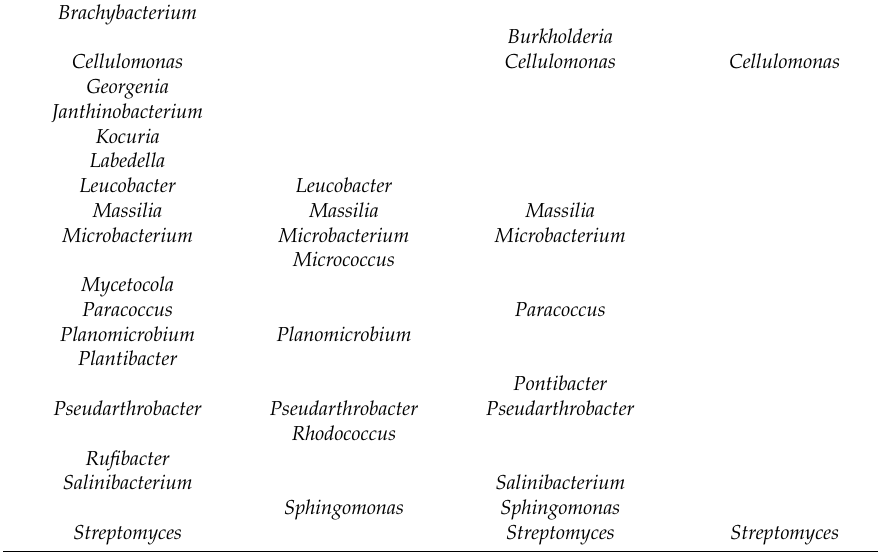
Table A3. The bacterial genera cultured from the Mojave Desert soil sample on different media. The table summarizes data of community structure diagrams and allows to compare bacterial diversity in a simpler